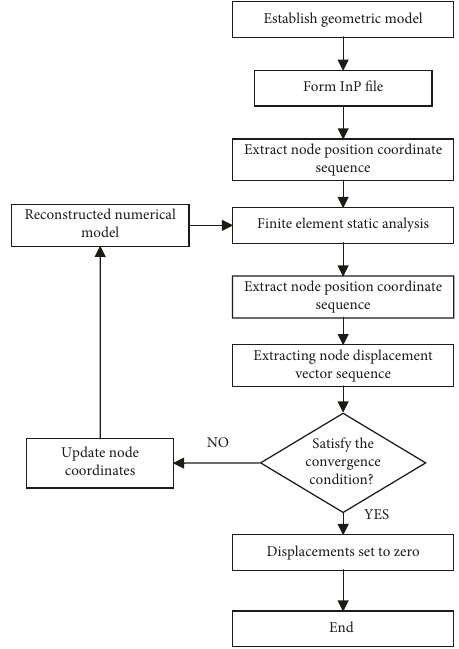
Figure 5: Ground stress balance